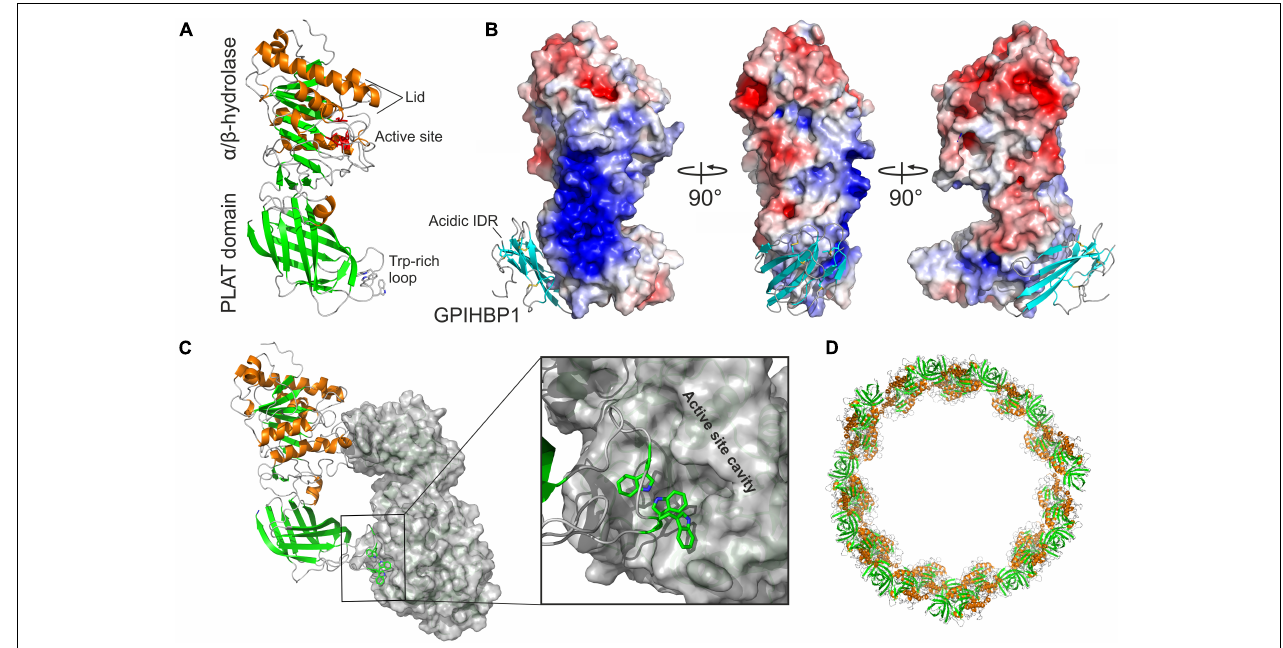
FIGURE 2 | Structure and oligomeric states of LPL. (A) The crystal structure of human LPL. β -strands are green , α -helices are orange , and tryptophan residues in the Trp-rich loop are shown as sticks as defined by in silico modeling (Birrane et al., 2019). (B) Heparin binding motifs in the LPL sequence fuse in the three-dimensional space to form a large basic patch covering 2400 Å 2 as illustrated by the electrostatic surface representation ( blue ). The LU domain of GPIHBP1 is bound to LPL’s PLAT domain; β -strands are cyan . GPIHBP1’s acidic and intrinsic disordered region (IDR) was not defined by the electron densities, but the position of the N-terminus from the LU domain suggests that the acidic domain projects toward the basic patch of LPL. (C) LPL crystalizes as a head-to-tail homodimer. One protomer is shown in a cartoon and the other as a gray surface representation. One of the two reciprocal dimer interfaces is shown in a close-up with the Trp-rich loop of one protomer occluding the active site of the other protomer. (D) In the presence of a high salt concentration or heparin, LPL may enter a higher oligomer state and form helical fibers (Gunn et al., 2020). The building blocks of these elongated fibers are the head-to-tail homodimers shown in (C) . Illustrations were generated with the PyMol Molecular Graphics System (Schrödinger, LLC) using PDB coordinates 6E7K and